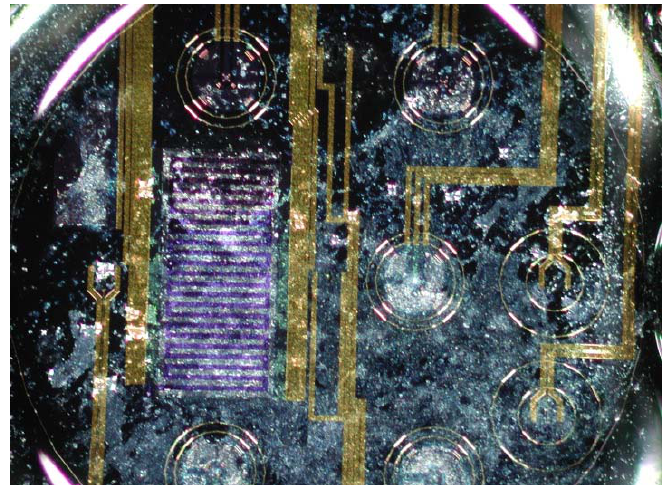
Figure 3. Scanning electron microscope image shows groups of cells arranged in monolayer growing on the chip. The CPCs can be seen as a grey veil covering the major part of